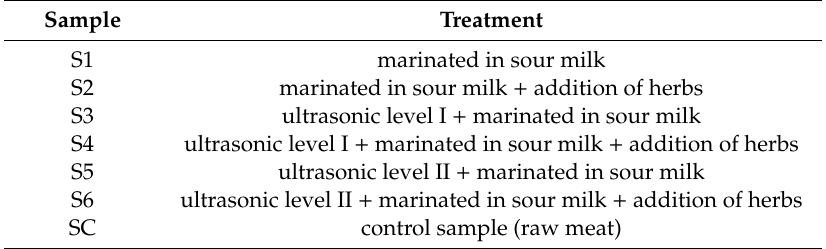
Table 8. Details of the experimental